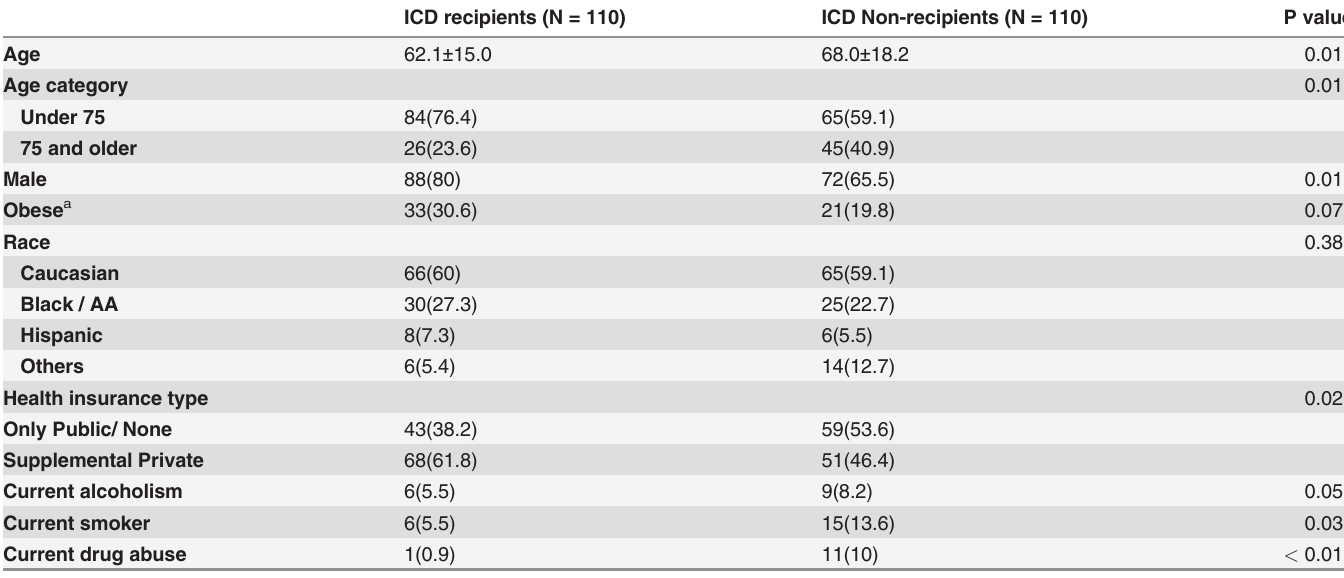
Table 1. Demographic Characteristics of ICD Recipients versus Non-Recipients.